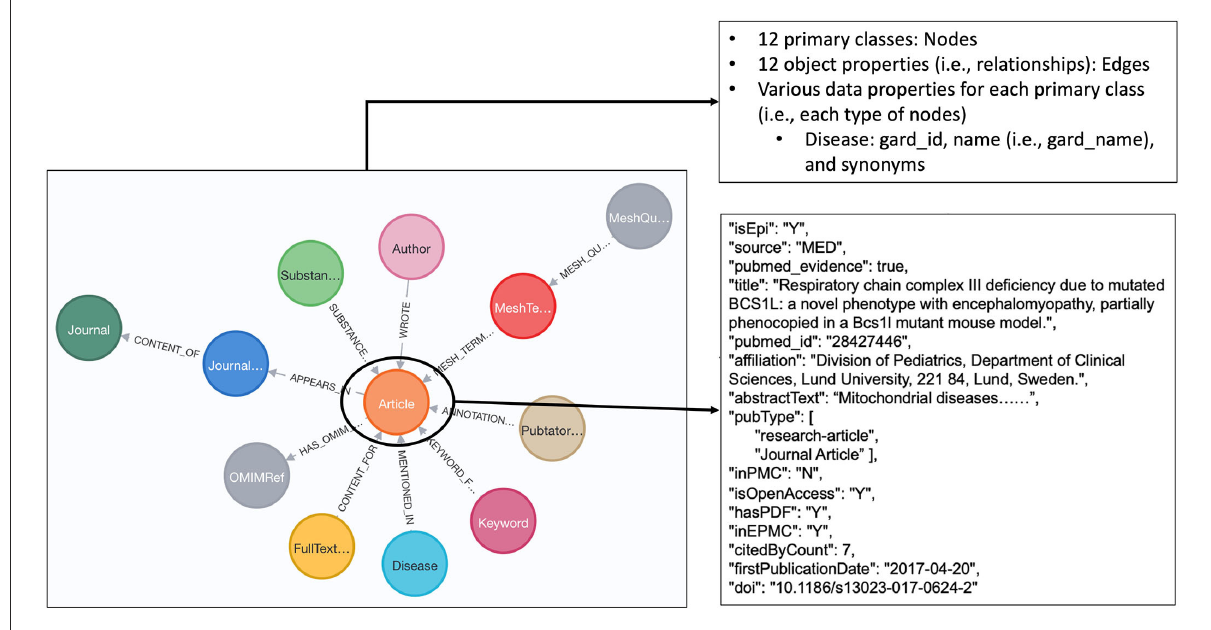
FIGURE3 Data model and an example of information (data properties) about one article node.